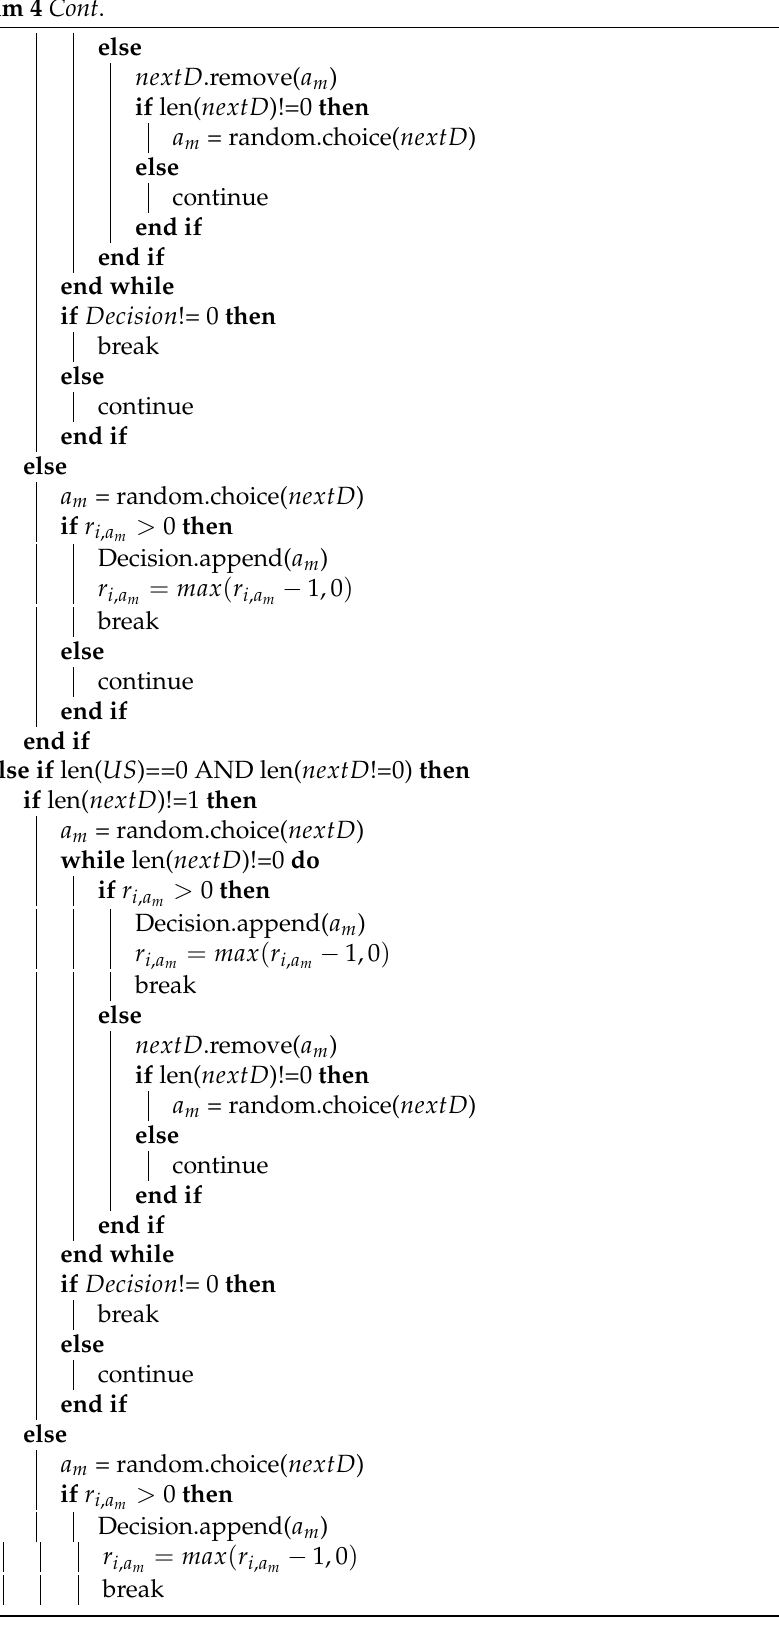
Algorithm 4 Cont